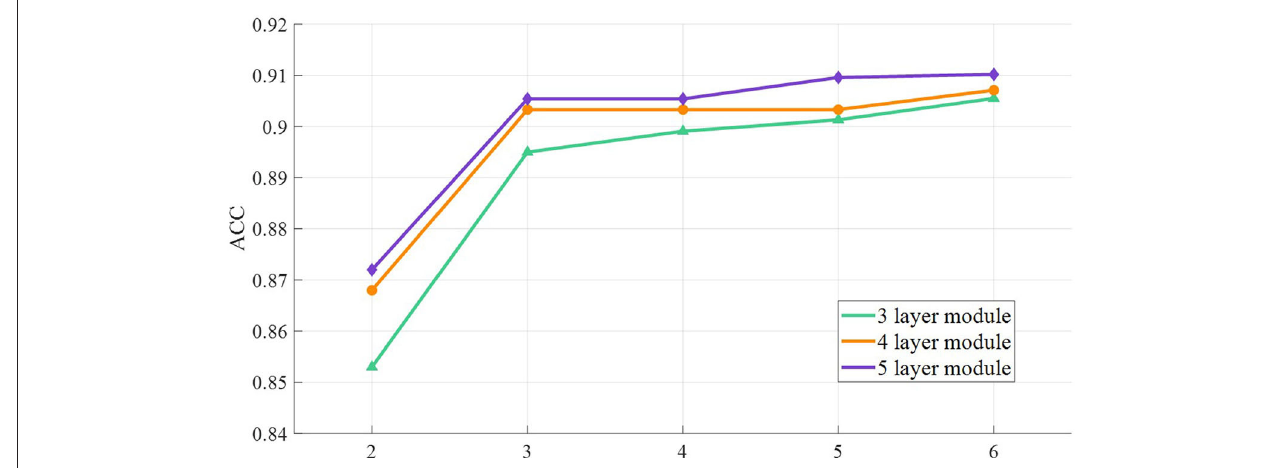
FIGURE 9 | Classification performance of multi-layer, multi-branch network architecture.